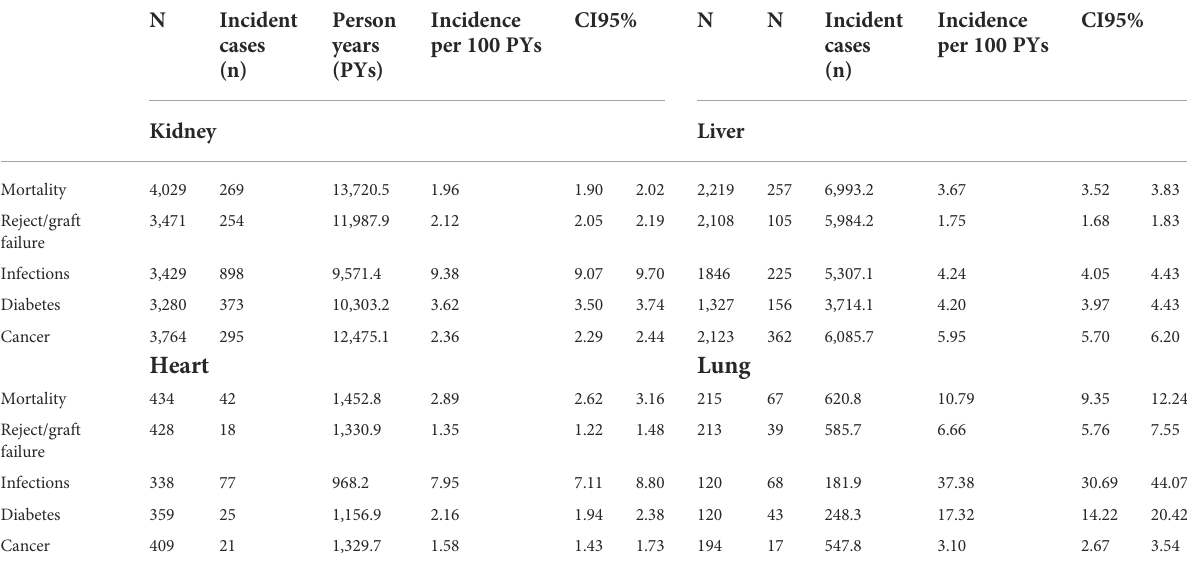
TABLE 3 Incidence rate by transplant